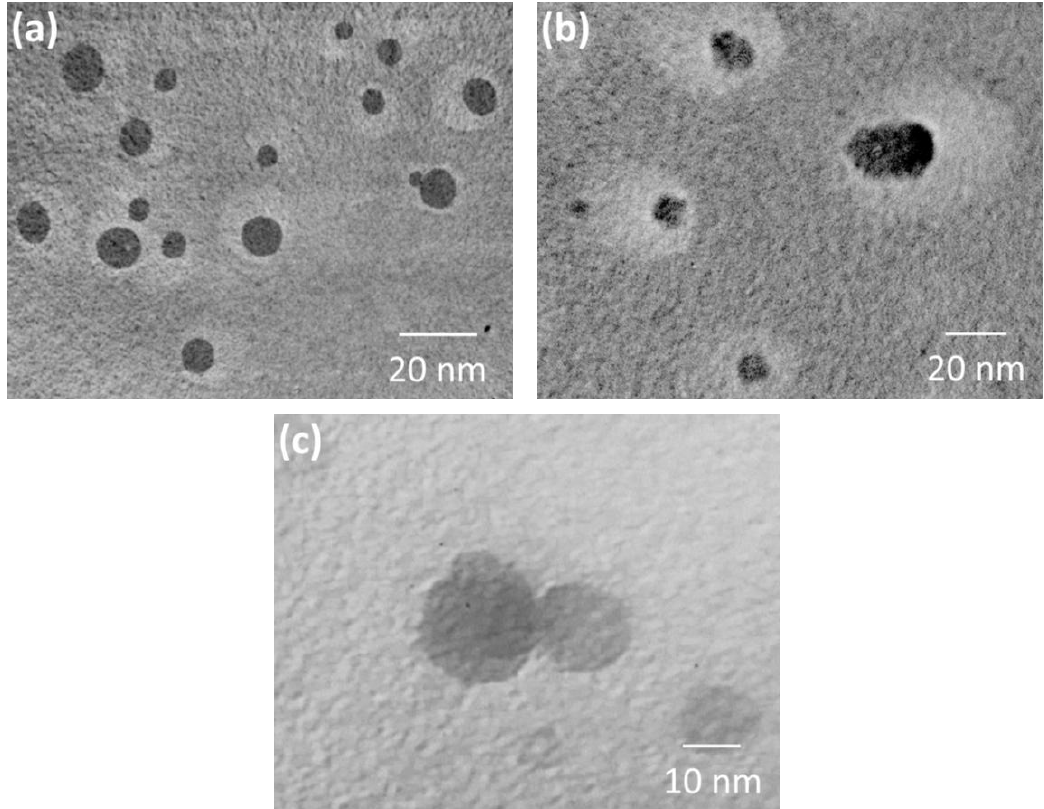
Figure 15. Transmission electron micrographs near the fracture surface of ( a ) 1 vol%